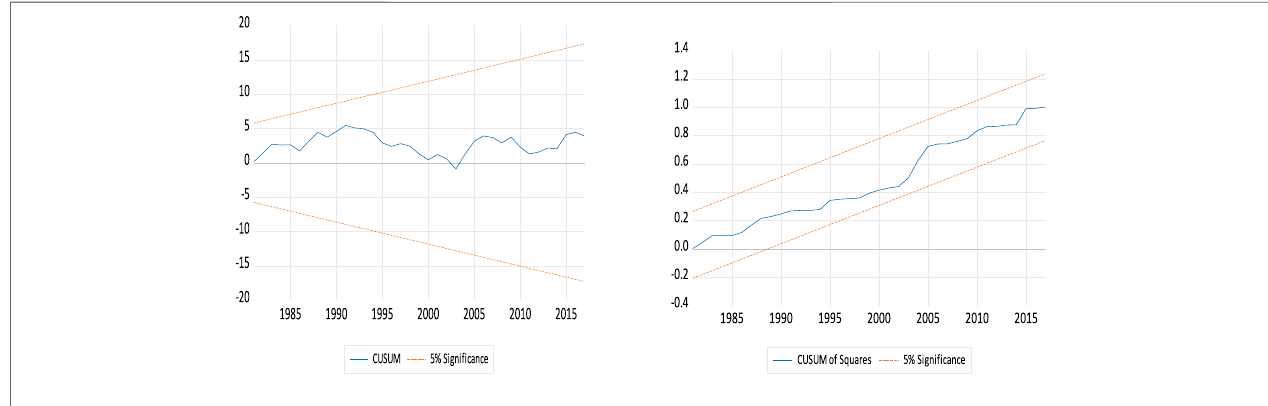
FIGURE 4 | Stability